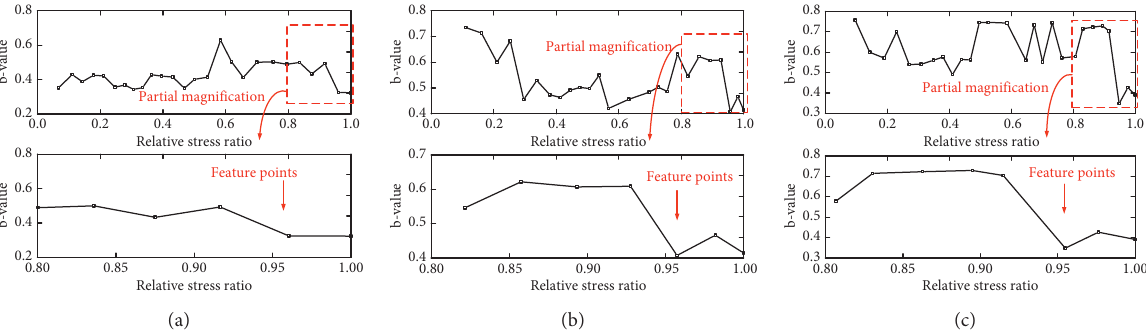
Figure 13: The variation rule of the acoustic emission b value during the process of weakly cemented sandstone failure under different dry-wet cycles. (a) N � 0. (b) N � 5. (c) N �